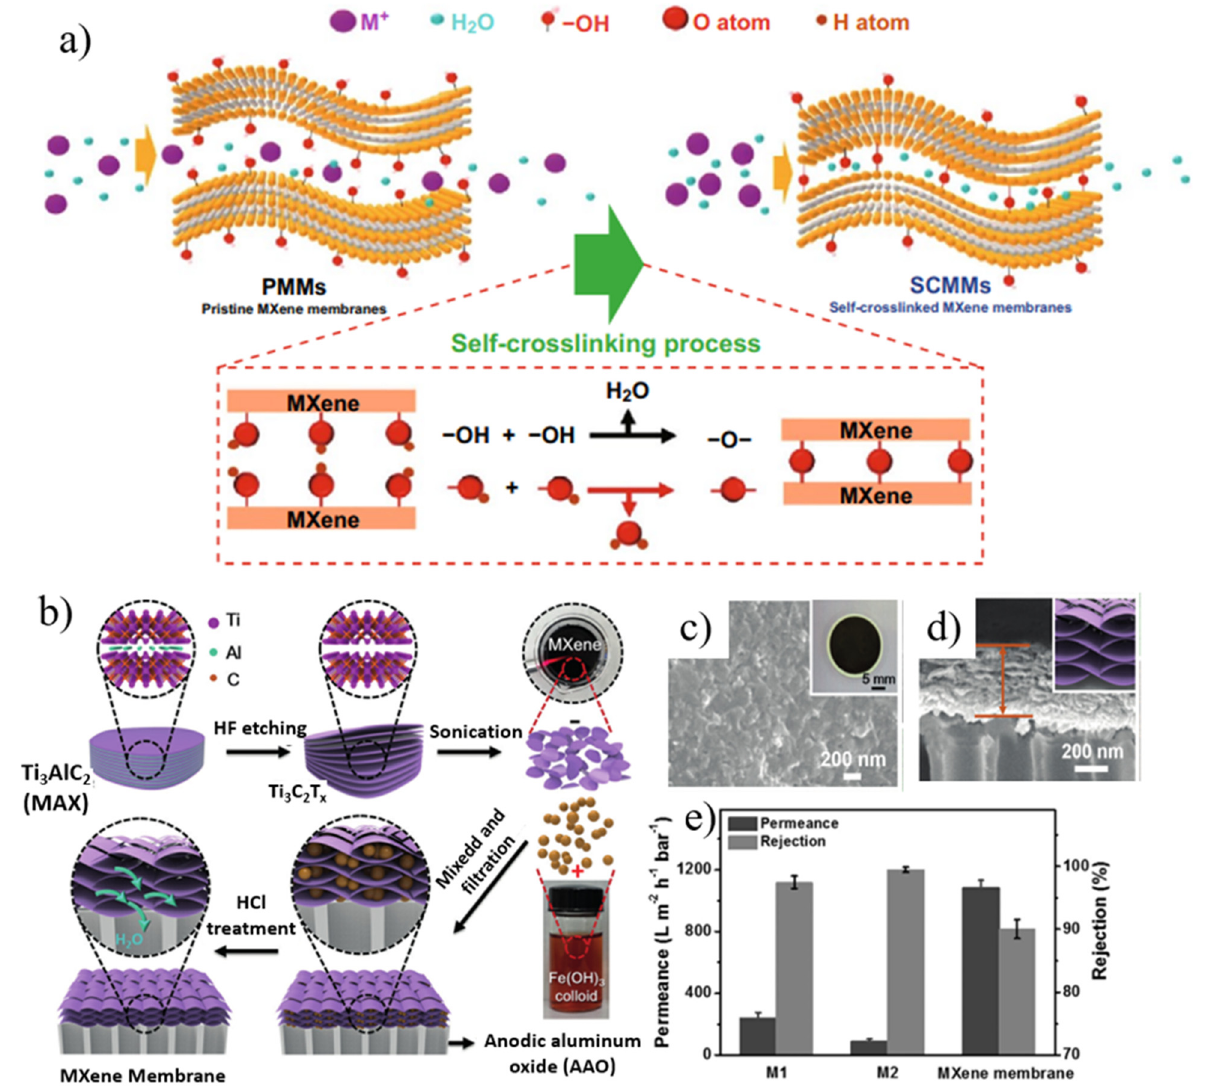
Figure 8. ( a ) Illustration of the self-crosslinking process. Reproduced with permission. ( b ) MXene membrane preparation. ( c ) SEM image (inset: macroscopic photograph) of the MXene membrane surface. ( d ) High magnification of SEM image of the cross-sectional view of the MXene membrane (inset: representation of the layered structure). ( e ) performance of MXene-based NLMs with en- larged interlayer spacing achieved by the intercalation and subsequent removal of colloidal Fe(OH) 3 . Reprinted with permission from [117,121]. Copyright (2019) Published by American Chemical Society. Copyright (2017) Published by Wiley-VCH Verlag GmbH & Co. KGaA, Wein- heim.